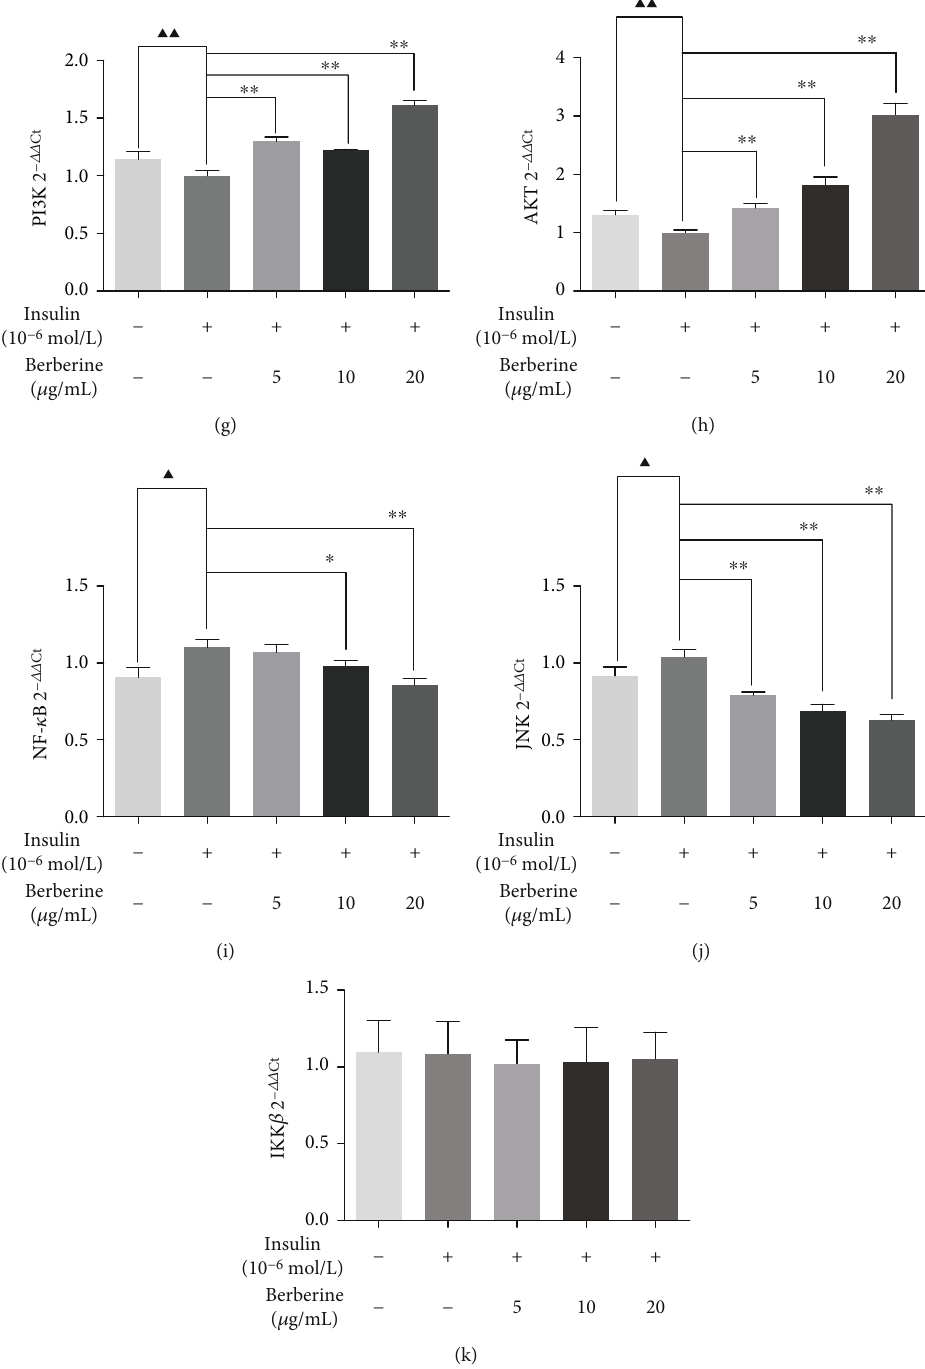
Figure 7: E ff ect of BBR on the mRNA expression level of targets in the PPM1B pathway in HepG2-IR cells. HepG2 cells without treatment served as a model group. The experiments were repeated three times and presented as mean ± SD . ▲ P < 0 : 05 and ▲▲ P < 0 : 01 , Con vs. model; ∗ P < 0 : 05 and ∗∗ P < 0 : 01 , model vs. BBR-treated